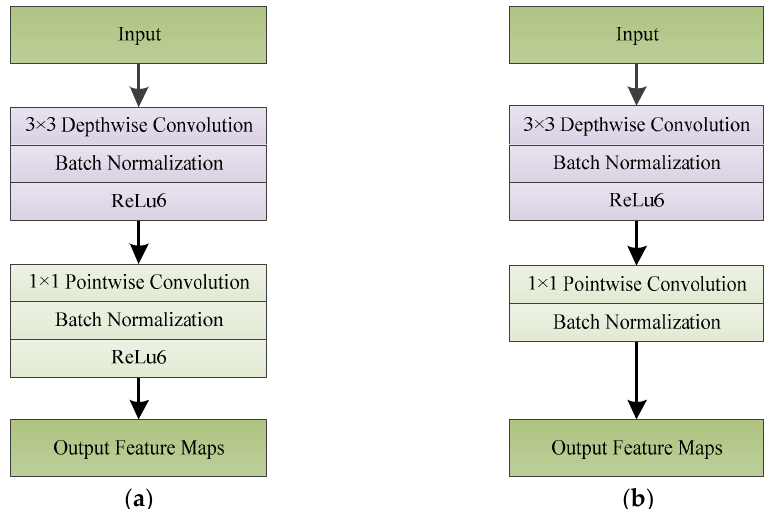
Figure 5. The basic structure of MobileNet: ( a ) unit in MobileNetv1 [66]; ( b ) unit in MobileNetv2 [65].